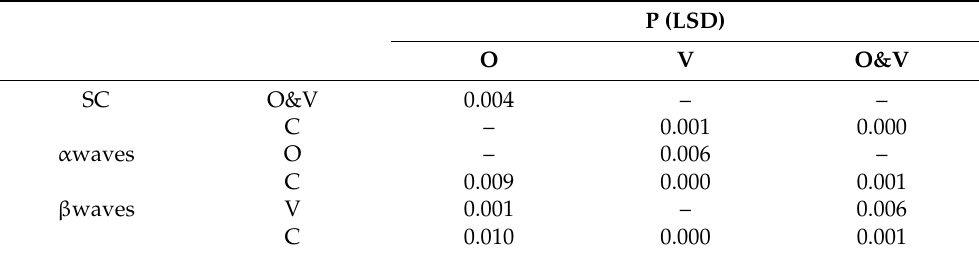
Table 2. Significance analysis of the influence of different stimulation methods on skin conductance, α waves and β waves (SC, α waves and β